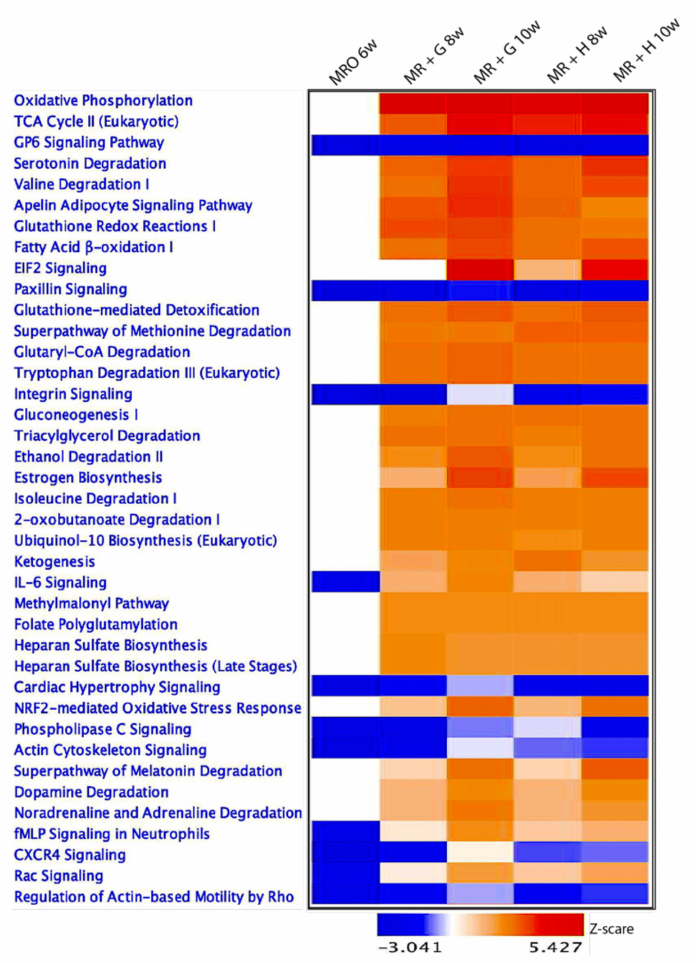
Figure 5. Comparison Analysis-Canonical pathways: Canonical pathway analysis reveals transcrip- tion reprogramming with clusters of the critical pathways to control the patterns of ruminal functions during the transition of pre-rumination to rumination in rumen epithelium. Heatmap shows com- parisons of individual temporal groups and feeding schemes (MRO 6w, MR + H 8w, MR + H 10w, MR + G 8w, and MR + G 10w) with the MRO 2w groups. The transcriptomes were first analyzed with IPA to identify the significant canonical pathways, and then a comparison was performed between individual temporal groups to the MRO 2w, respectively. The transcriptome atlas of the preweaning groups (i.e., MRO 6w versus MRO 2w) revealed no significant up-or down-regulated canonical pathways. However, many canonical pathways, especially those related to metabolism, were activated after the 2 to 4 weeks of supplemented solid feeding in the form of hay or